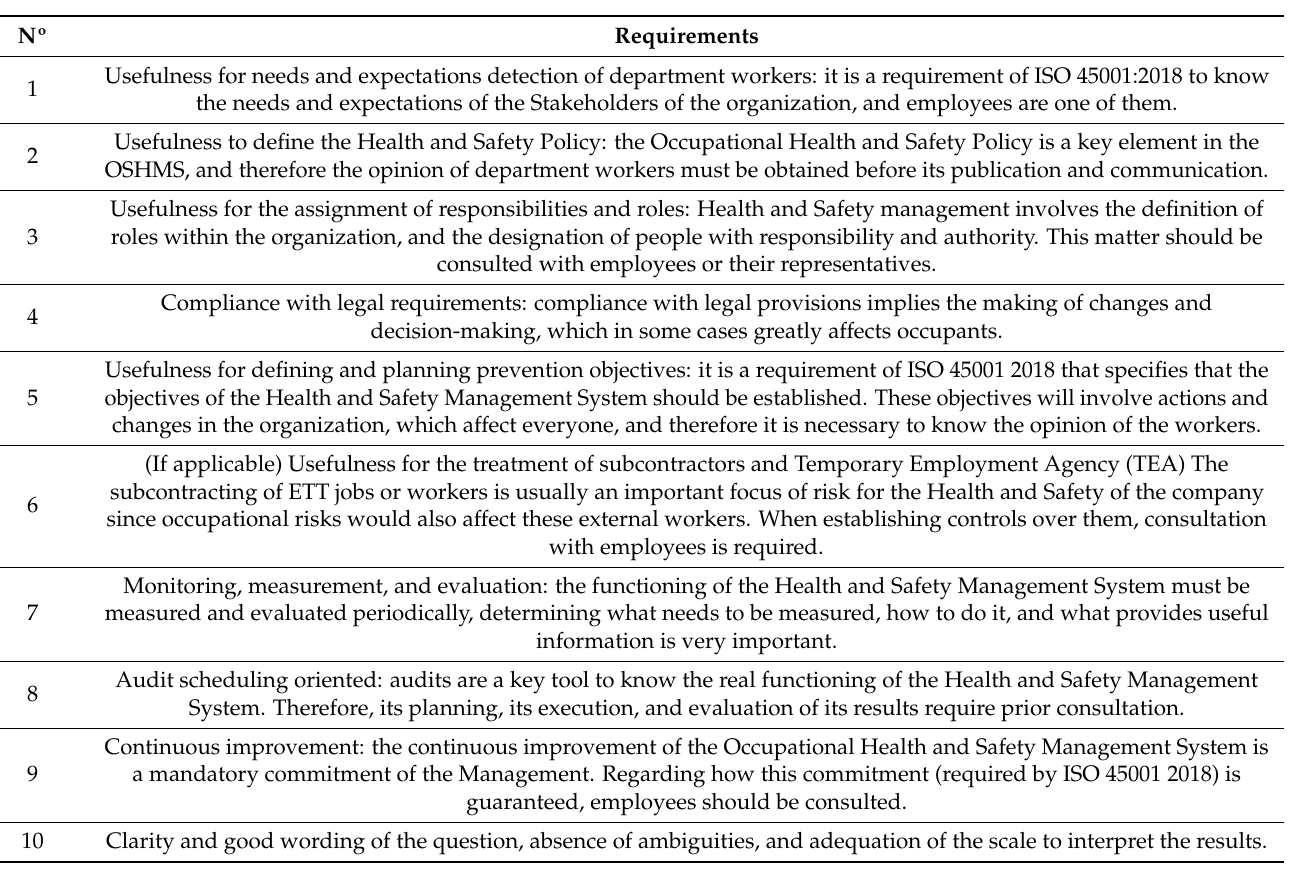
Table 3. Requirements for the questions raised for each working group in the context of ISO